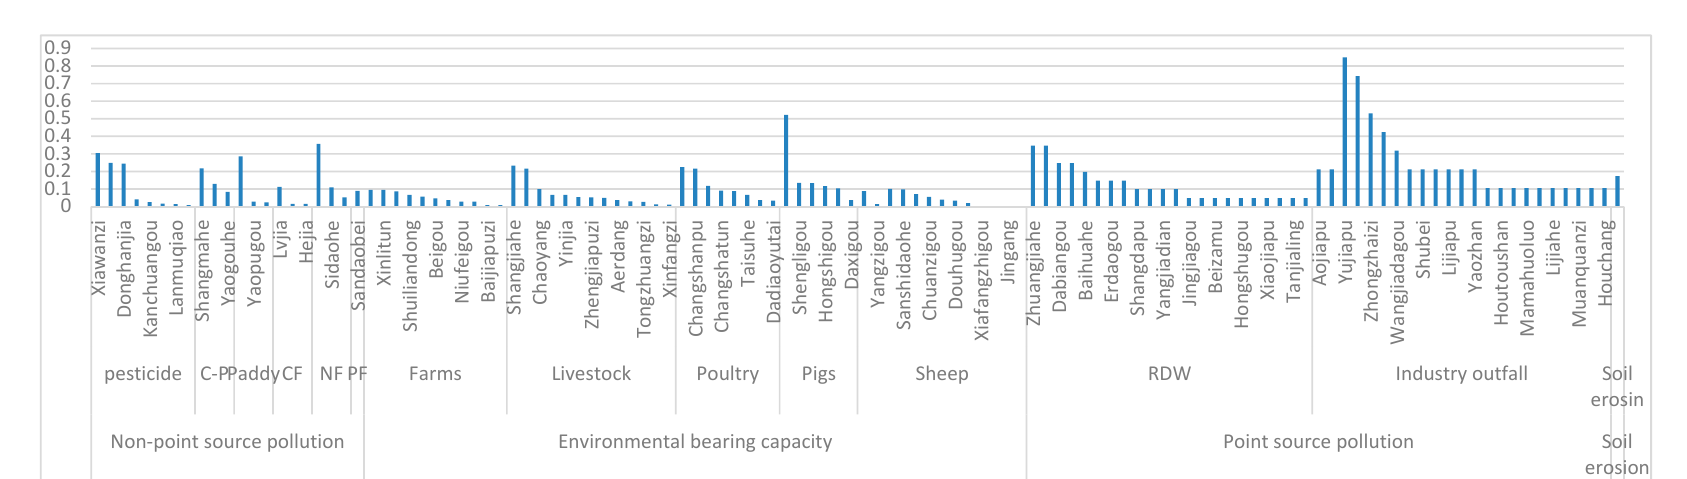
Figure 3. The classification figure of the small watersheds. Note: C-P means phosphorus in organic fertilizer; CF means compound fertilizer, PF means phosphorus fertilizer; NF means nitrogen fertilizer.